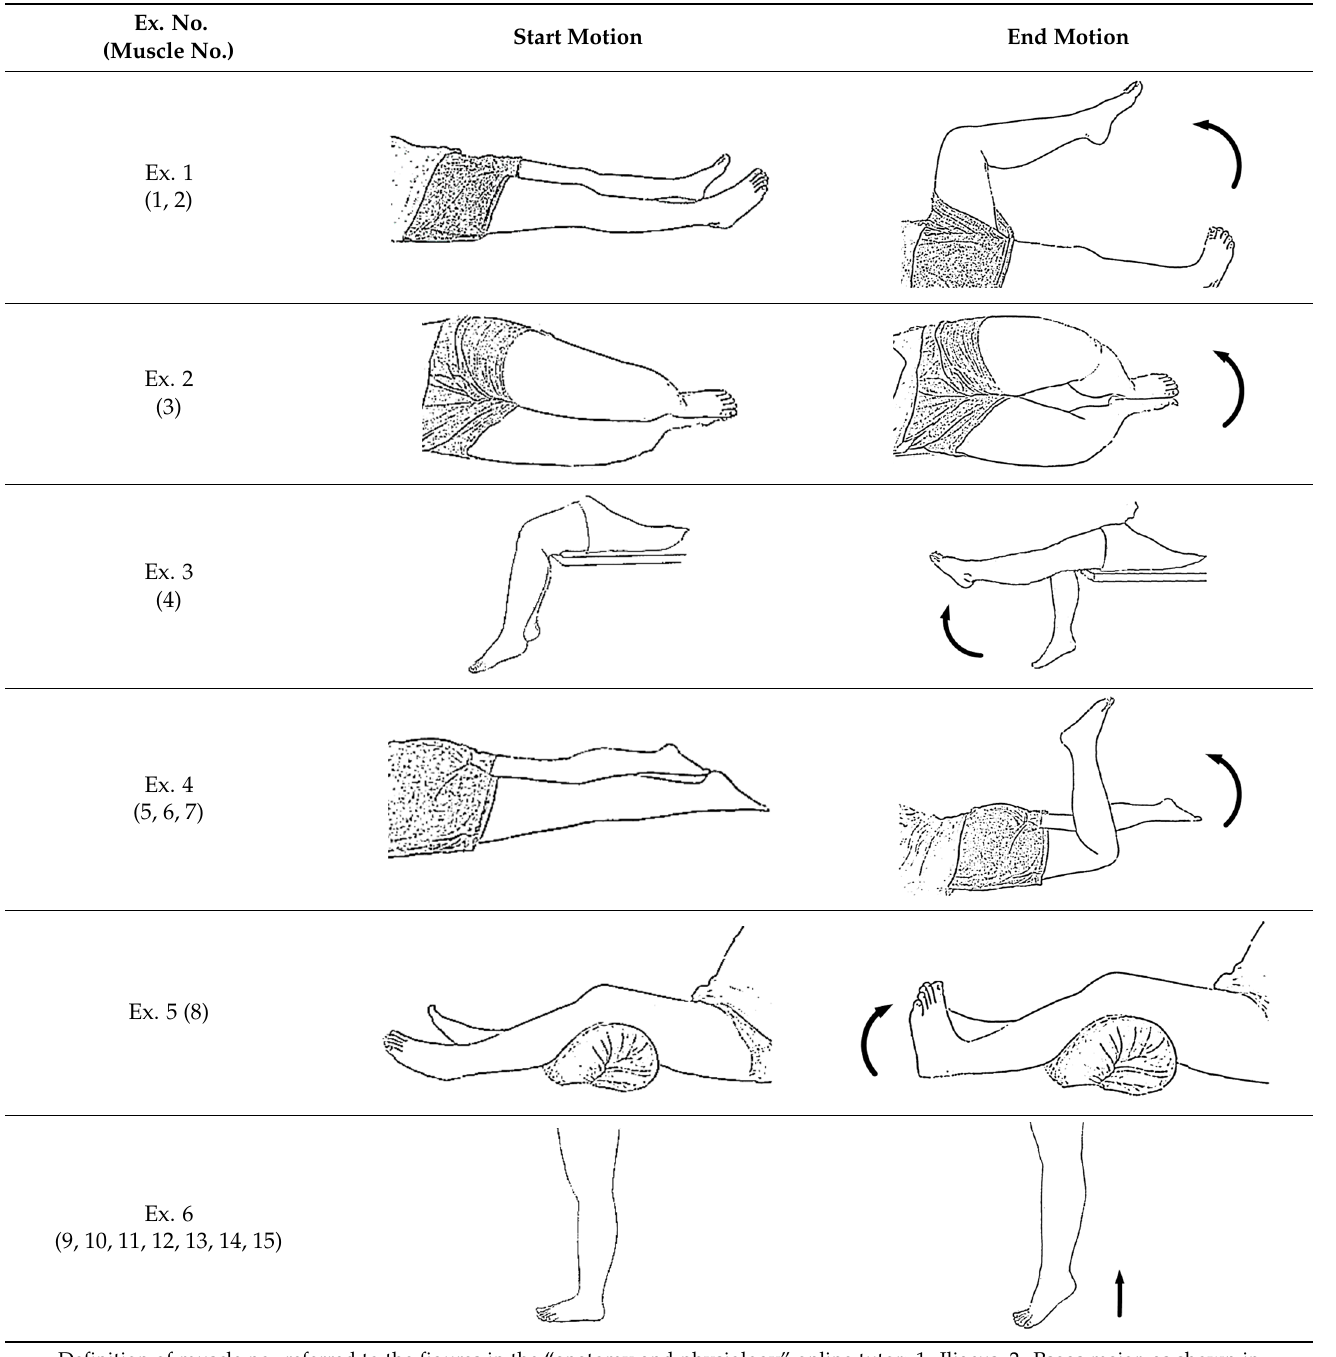
Table 1. The lower-limb rehabilitation exercises and the rehabilitated parts [35–37]. Ex. No. Start Motion (Muscle no.)